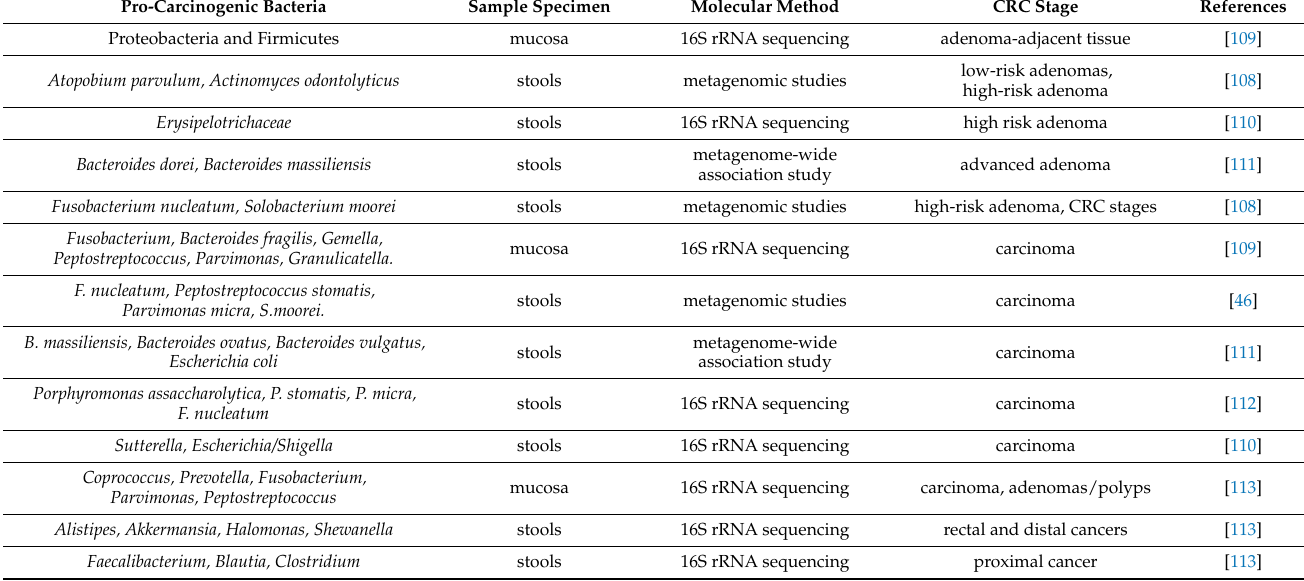
Table 2. Microbial signatures in sporadic